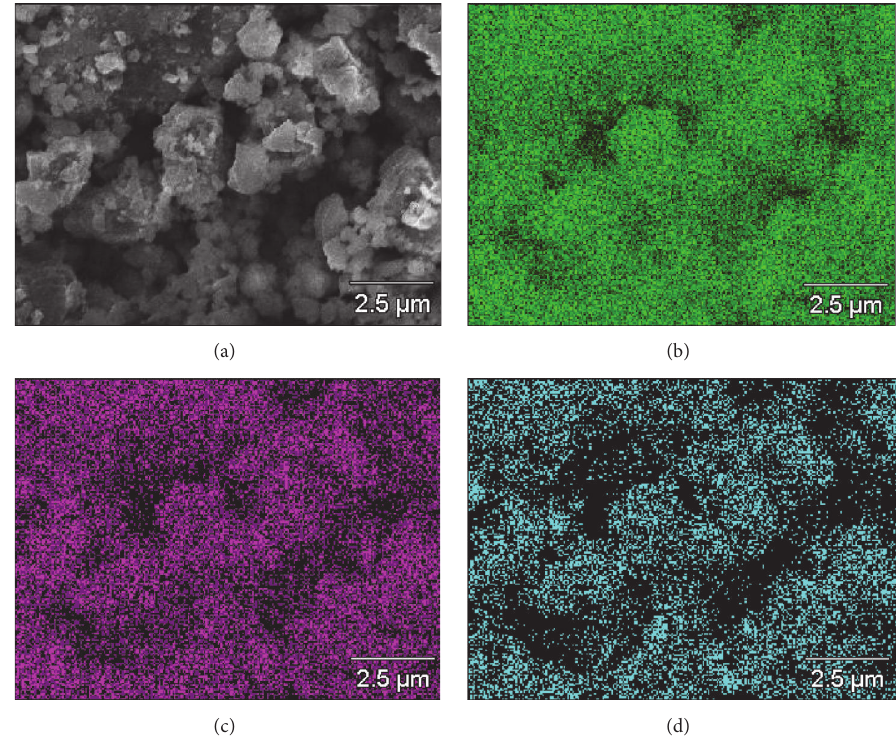
Figure 4: (a) STEM bright field image of the composite material and corresponding EDX distribution maps for (b) Si, (c) O, and (d) Cu.